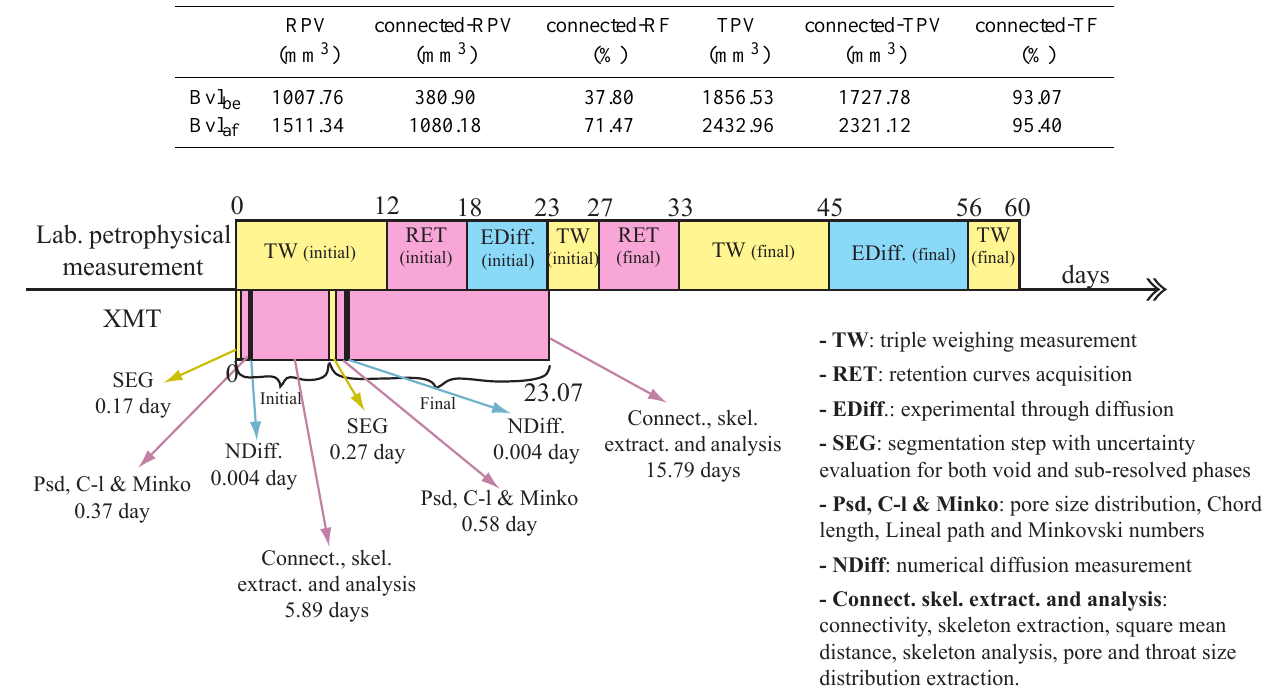
Table 4. Resolved (RPV) and total (TPV) phase volume [mm 3 ] and connected resolved (connected-RPV) and total (connected-TPV) phase volume [mm 3 ] with the respective connected resolved (connected-RF) and total (connected-TF) fraction [%].